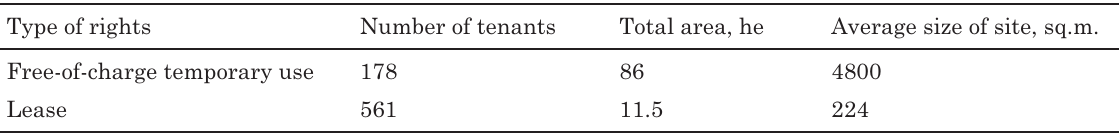
Table 4. Free temporary use and lease of land in Osh Type of